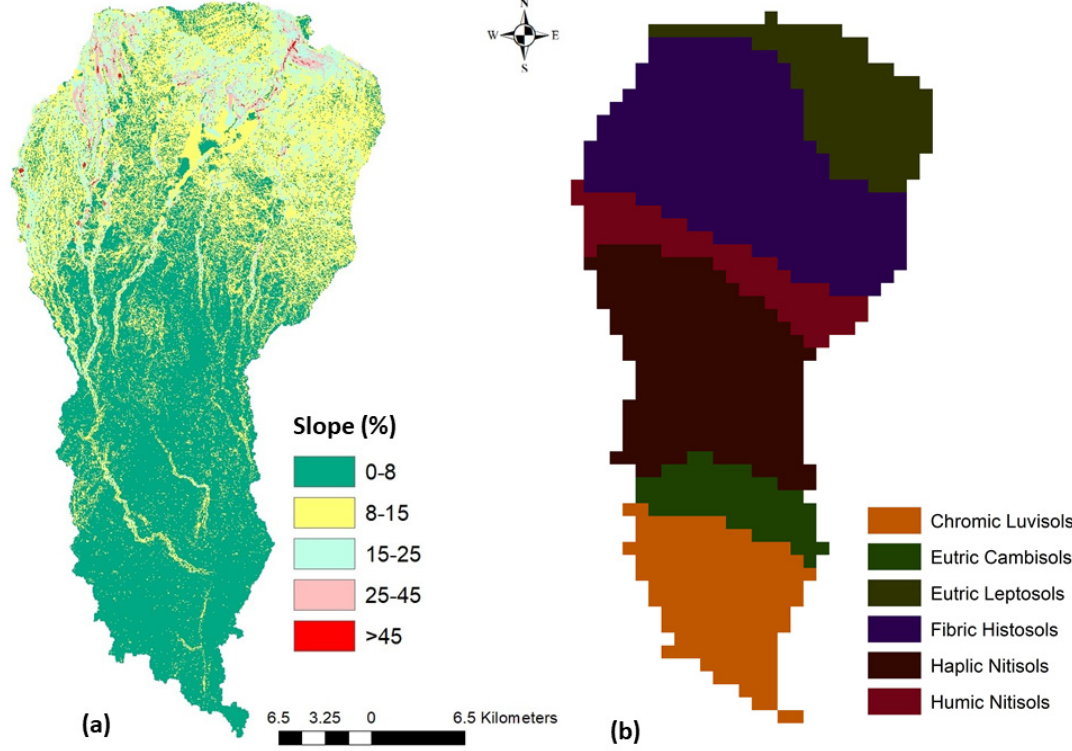
Figure 2. Slope (a) and soil maps (b). Figure 2. Slope ( a ) and soil maps ( b